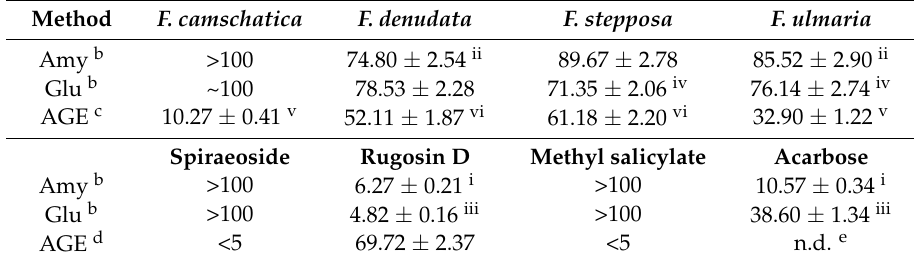
Table 6. Inhibitory effect on amylase (Amy), α -glucosidase (Glu) and AGEs formation (AGE) of four meadowsweet floral tea decoctions and reference compounds a . F.